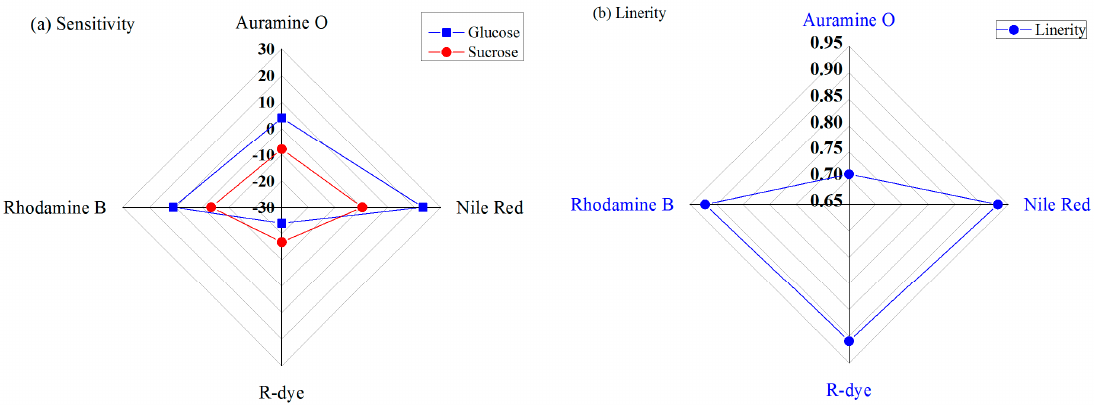
Figure 8. Resopnse of the IDC glucose biosensing system for various dye-containing sensing membranes: ( a ) sensitivity; and ( b ) linearity.